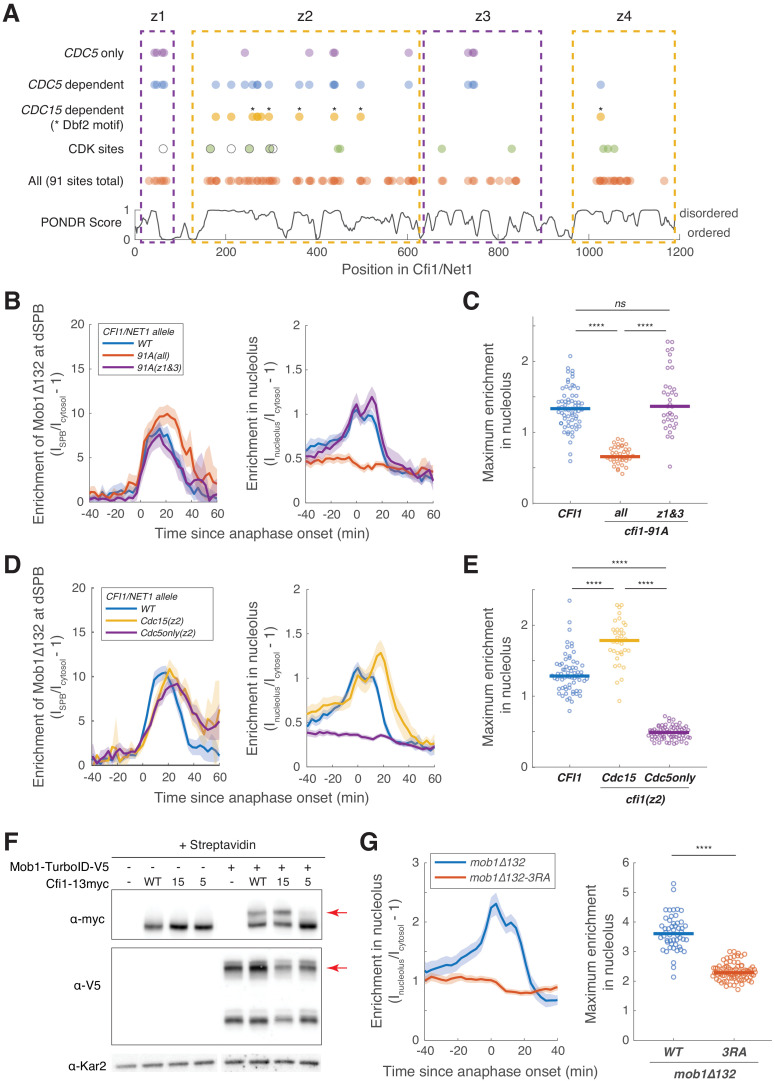
Cdc5 promotes Dbf2-Mob1’s nucleolar localization by phosphorylating Cfi1/Net1.(A) Distribution of all, CDK sites, CDC15- and CDC5-dependent phosphorylation sites (Supplementary file 4) and disordered regions in Cfi1/Net1. For CDK sites, open circles represent sites identified and mutated in Azzam et al., 2004 (cfi1/net1-6Cdk) and filled circles represent sites identified in Holt et al., 2009. Dashed boxes denote the four zones. (B–E) Localization of Mob1Δ132 in CFI1/NET1 (A41411, n = 67 cells for B and C and 66 cells for D and E), cfi1-91A mutants (A41412 and A41413, n = 36 and 35 cells), cfi1-Cdc15(z2) (A41593, n = 34 cells) or cfi1-Cdc5only(z2) (A41594, n = 69 cells). Cells were grown at 25°C in SC medium + 2% glucose and imaged every 3 min for 4 hr. (F) Streptavidin gel-shift assays to probe the interactions between TurboID-tagged Mob1 and different CFI1/NET1 alleles (from left to right: A2587, A41596, A41597, A41598, A41379, A41611, A41612, A41613). -, not tagged; WT, wild-type Cfi1-13myc; 15, Cfi1-Cdc15(z2)−13myc; 5, Cfi1-Cdc5only(z2)−13myc. Cells were grown at room temperature in YEP + 2% glucose and lysates were treated with streptavidin and immunoblotted as indicated. Red arrows highlight biotinylated proteins. (G) Enrichment of Mob1Δ132 (A41664, n = 50 cells) or Mob1Δ132-3RA (A41665, n = 85 cells) in the nucleolus. Cells were grown at 25°C in SC medium + 2% glucose and imaged every 3 min for 4 hr. For graphs in (B–E and G), solid lines represent the average of single cell traces aligned to anaphase onset. Shaded areas represent 95% confidence intervals. For maximum enrichment, each dot represents a single cell. Solid lines represent the median. ****p<0.0001 by two-sided Wilcoxon rank sum test.